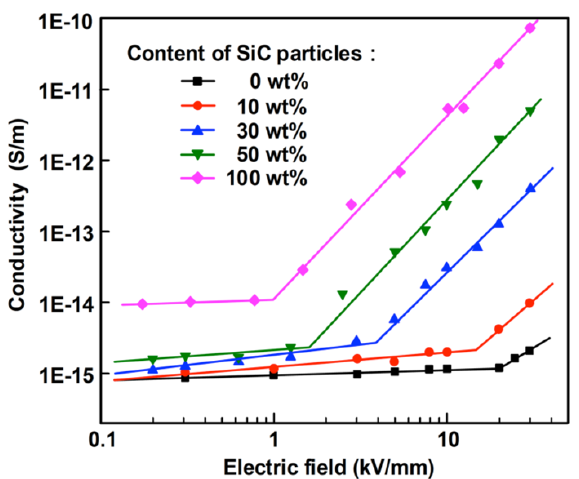
Figure 15. Relationship between conductivity and electric field for SiR/SiC composites. © 2021 IEEE. Reprinted, with permission, from [59]. Table 7. Nonlinear properties of composites involving SiC as a filler: effect of filler concentration